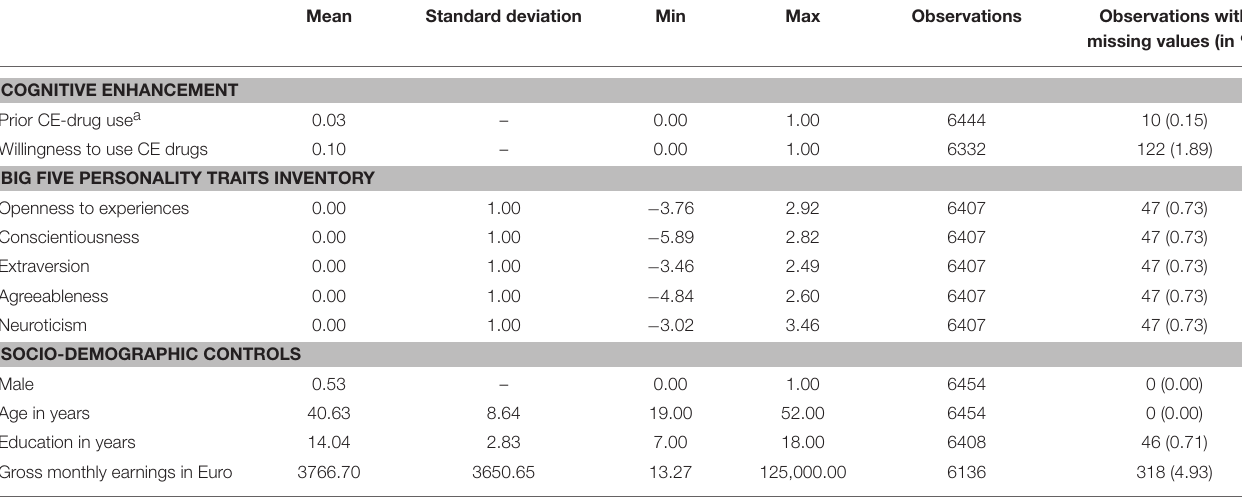
TABLE 1 | Descriptive statistics with non-imputed data. Mean Standard deviation